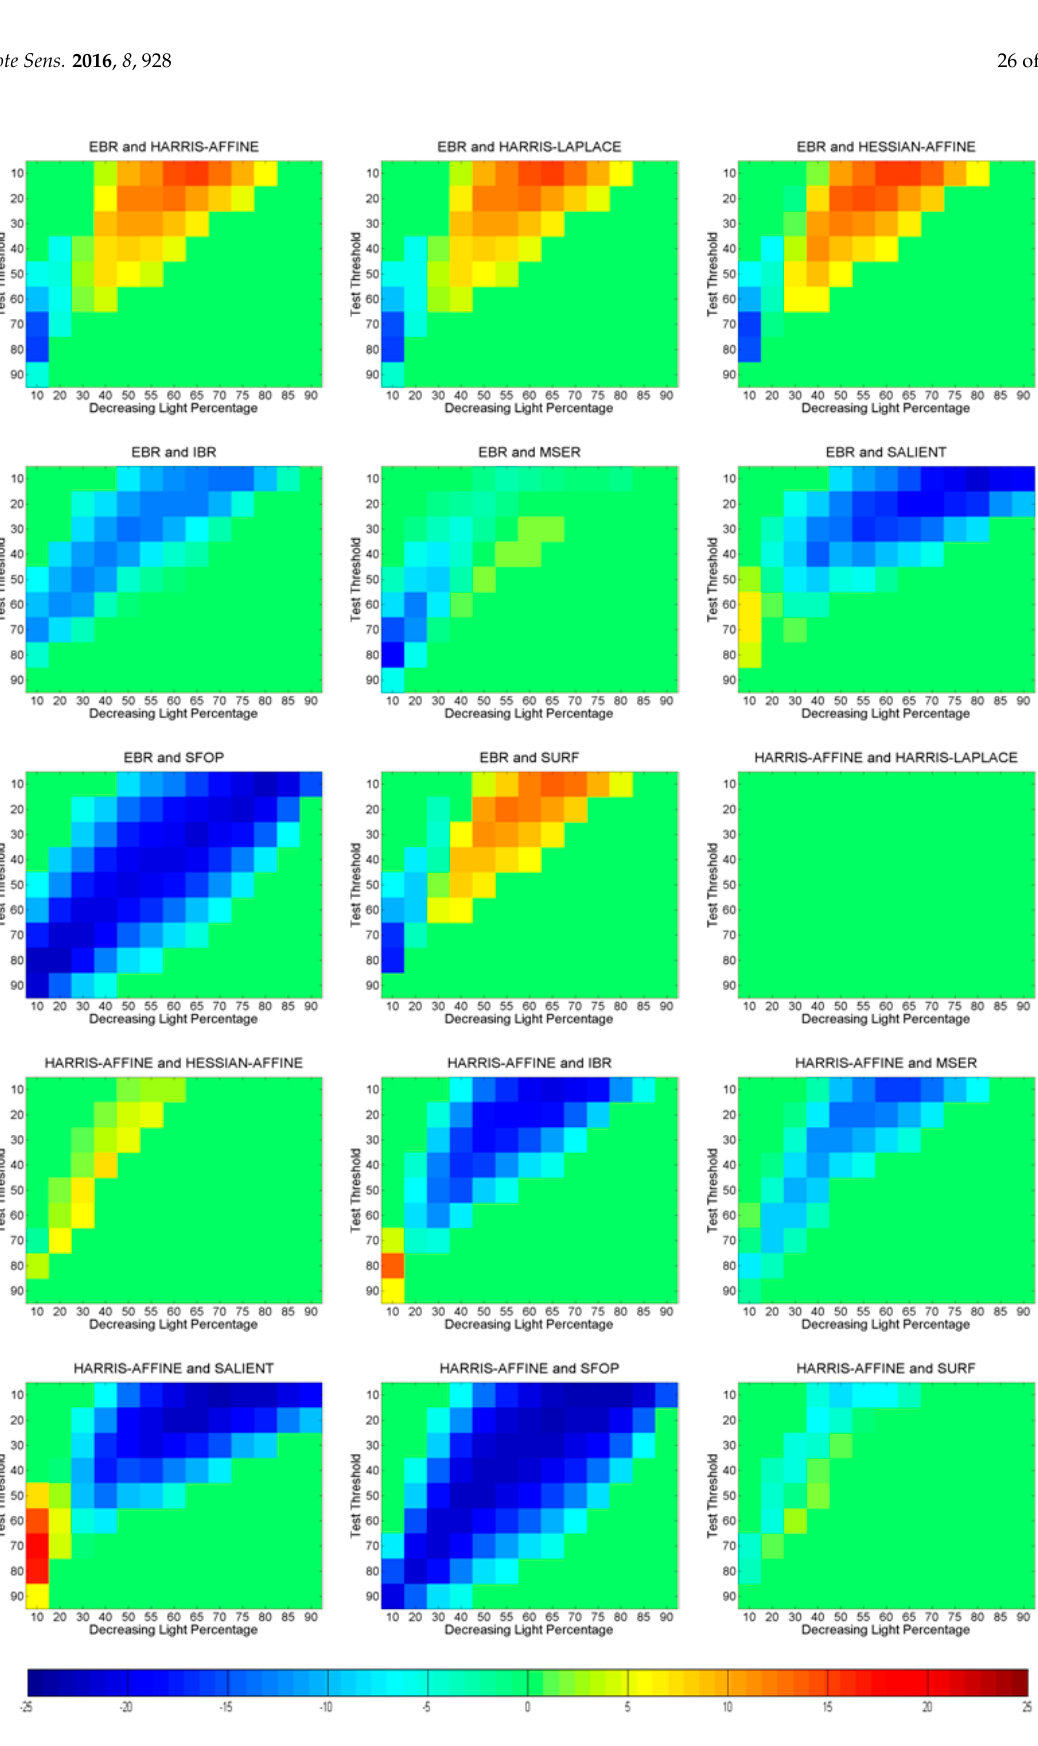
Figure 17. Results of uniform light changes for EBR and Harris-Affine with the other detectors showing Z -scores; positive Z -scores indicate that the first detector is better than the second whereas the negative values show the converse.